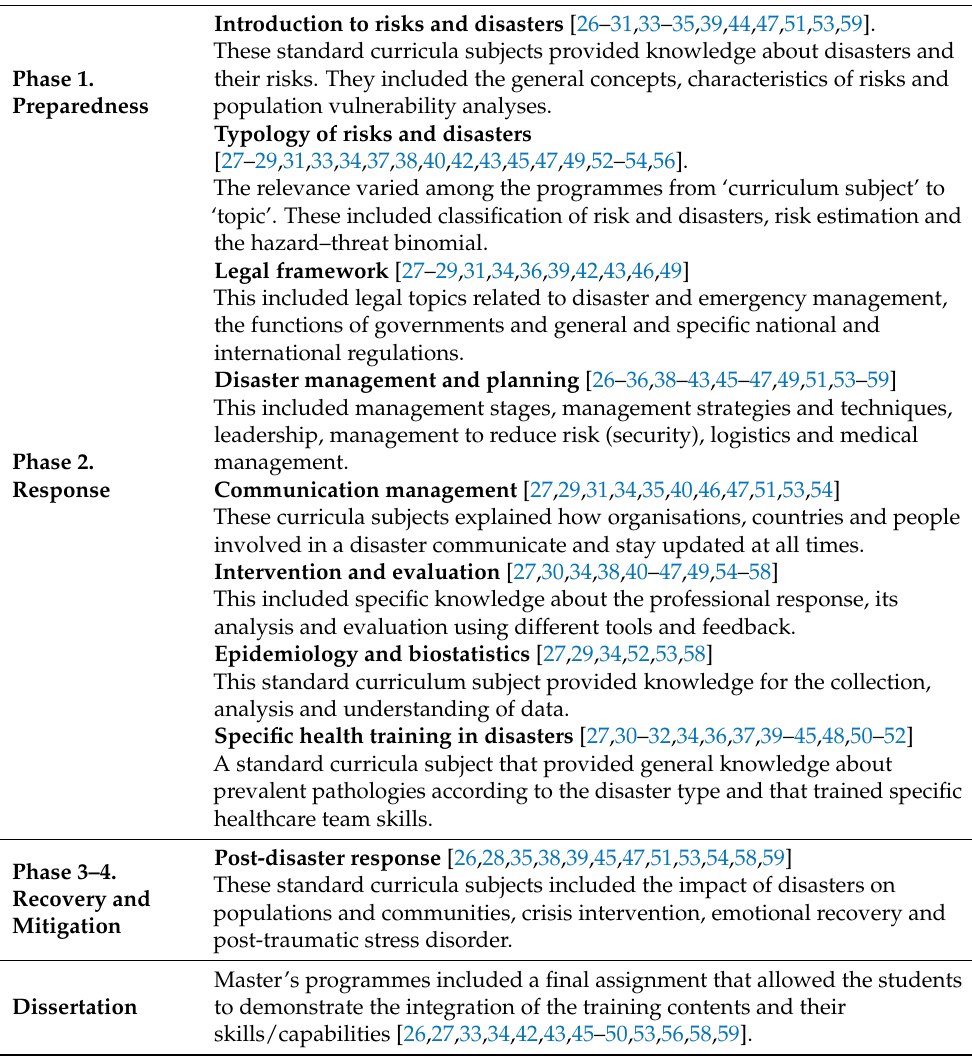
Table 2. Categories and Subcategories of Disaster Management, framed within Blanchard’s four phases of disaster management